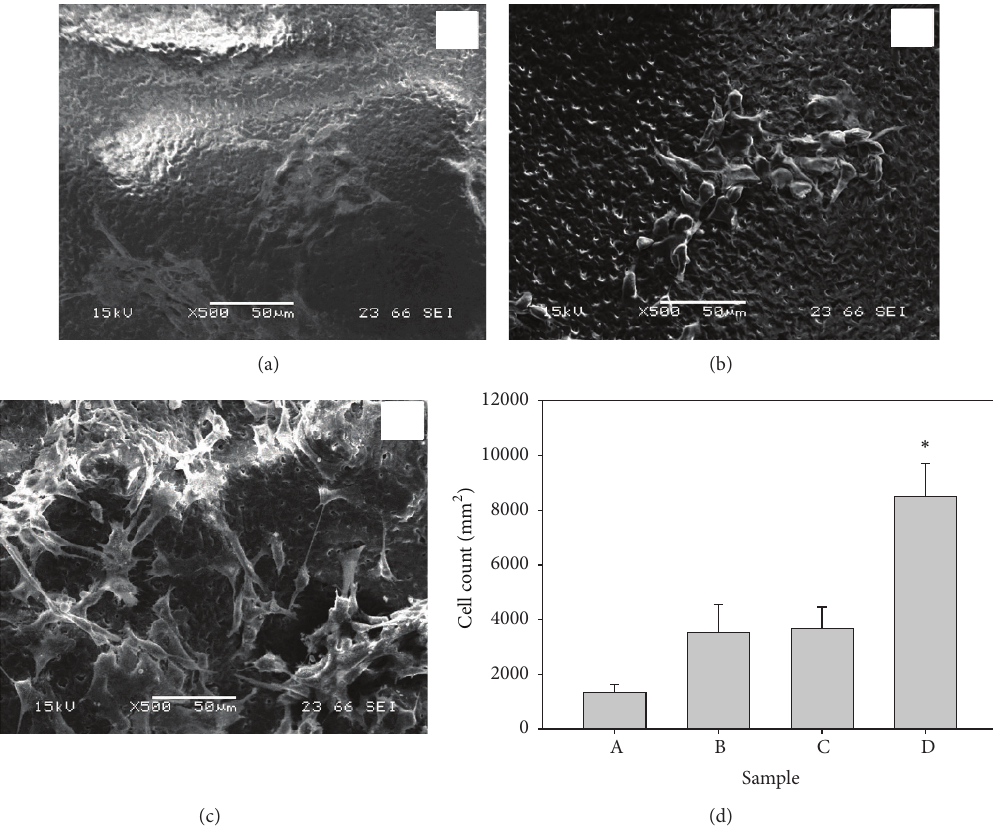
Figure 4: Representative SEM images of the primary osteoblastic cells cultured on the testing materials for 4 days: panel (a): sample A, panel (b): sample C, and panel (c): sample D. Panel (d) summarizes the cell numbers per mm 2 membrane on each group, using a computerized image analysis system ( ∗ 𝑃 < 0.05